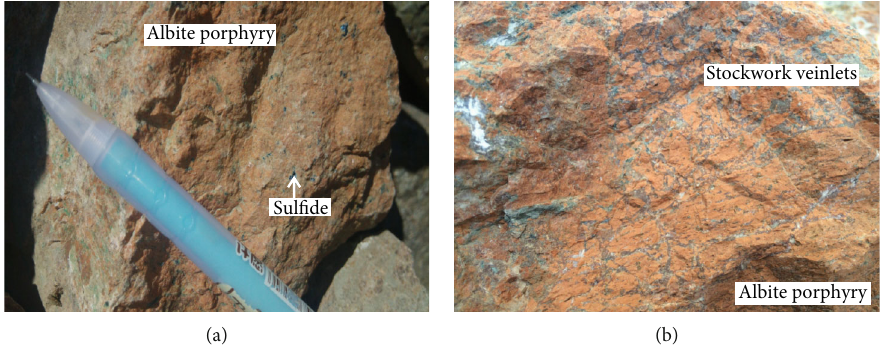
Figure 4: Structure of ore in porphyry deposit 109: (a) disseminated ore and (b) stockwork veinlet ore.